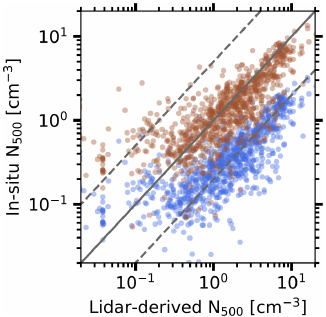
Figure 14. In situ measured N > 500 nm against the lidar-retrieved N > 500 nm when assuming a lidar-ratio typical for marine or conti- nental particles (including data available from May 2019 to March 2020) in blue and brown dots,